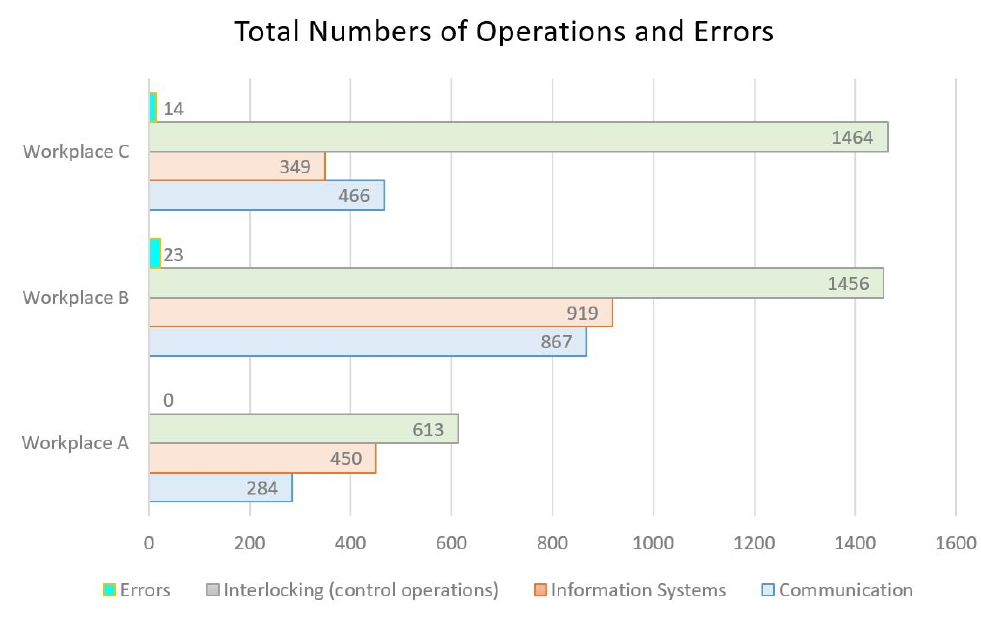
Figure 9. Distribution of operations and errors over the observed period of 18